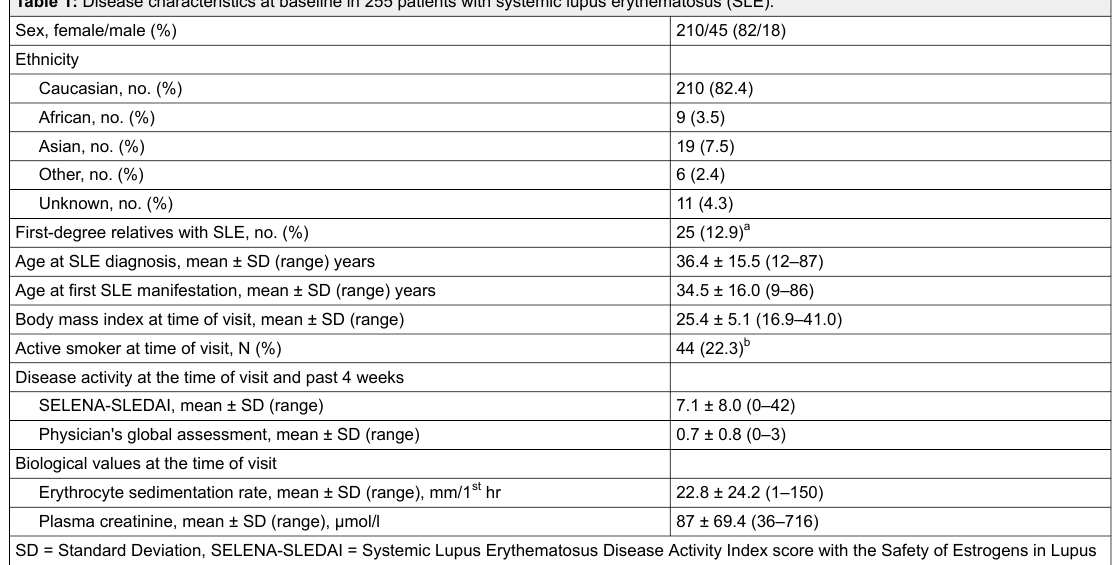
Table 1: Disease characteristics at baseline in 255 patients with systemic lupus erythematosus (SLE). Sex, female/male (%)